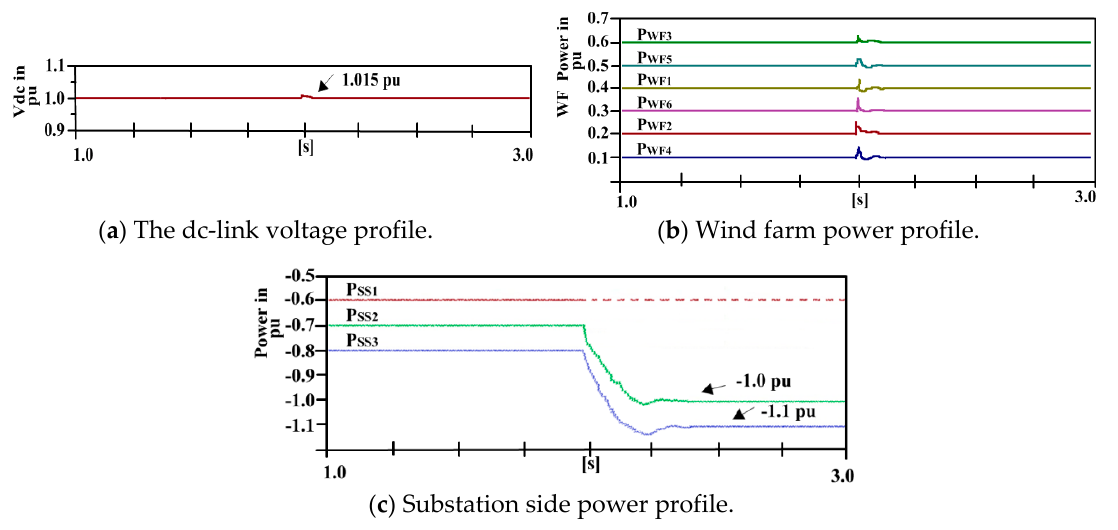
Figure 13. Disconnection of GS-VSC1 within the SS ring of the 2WF-SSRT.